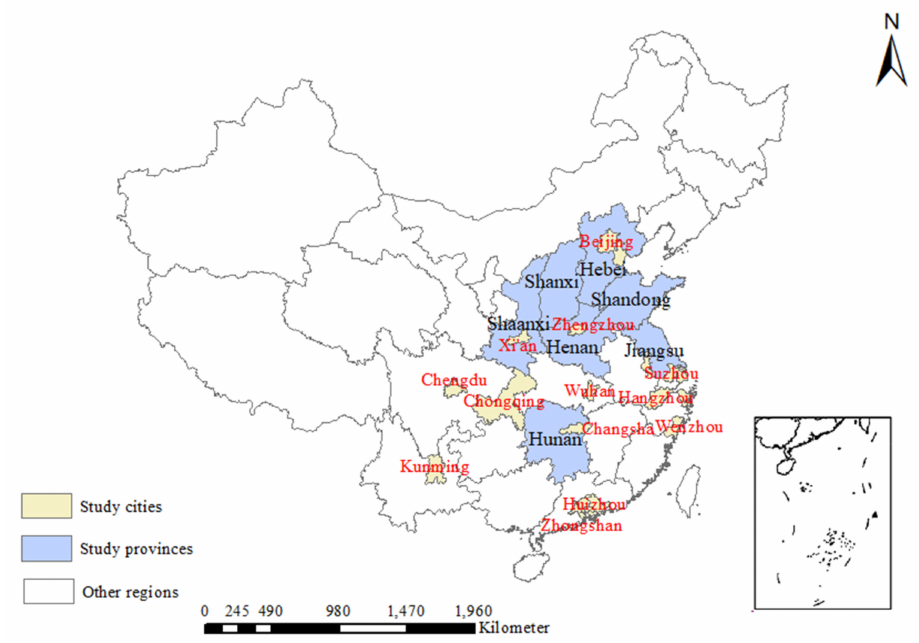
Figure 2. Study area, including 21 cities and 7